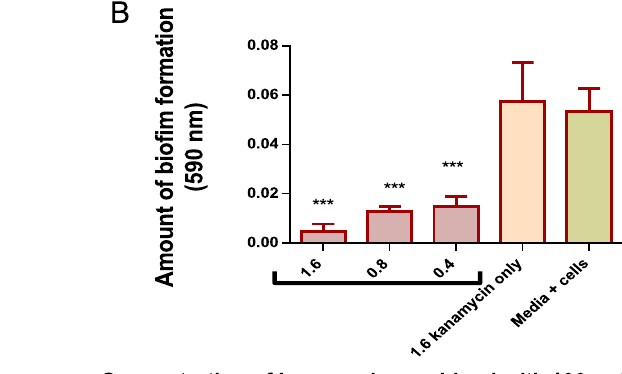
Fig. 7 The effect of combining P. curatellifolia ethanol extract with kanamycin. a M. smegmatis was incubated in a medium containing 1.6 μ g/ml kanamycin and varying ethanol extract concentration for 72 h. The amount of biofilm that had formed was determined by staining the biofilms with crystal violet, dissolving the crystal violet on the stained biofilms and spectrophotometrically measuring the amount of dye. b M. smegmatis was incubated for 72 h in a medium containing 100 μ g/ml ethanol extract and varying concentration of kanamycin from MIC value to quarter MIC value. The Error bars indicates the standard deviation from mean ( n = 4). Dunnet ’ s multiple comparison test was used to compare columns using graph pad prism 5 software. The asterisks (*) indicate statistical significant differences with the growth control (media + cells) * < 0.05 *** <